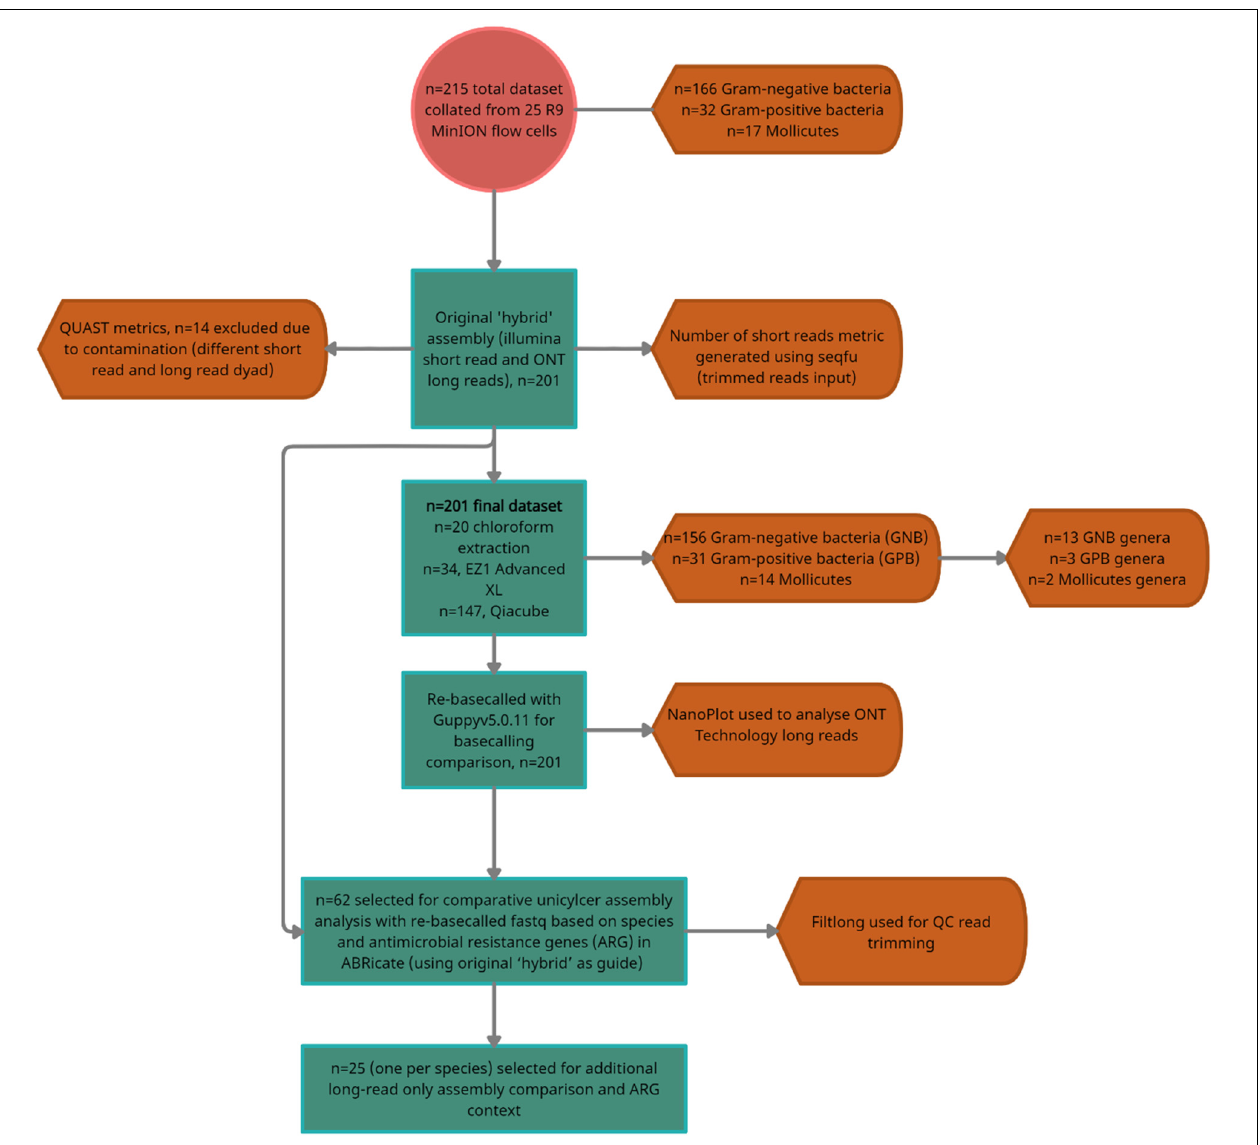
FIGURE 2 | A flow diagram summarizing the dataset, number of exclusions and the number of isolates selected for the two-stage downstream analyses; comparative hybrid assembly (Unicycler) with re-basecalled (Guppy v5.0. 11) fastq ( n = 62/200), and additional comparison with multiple long read assemblers ( n =